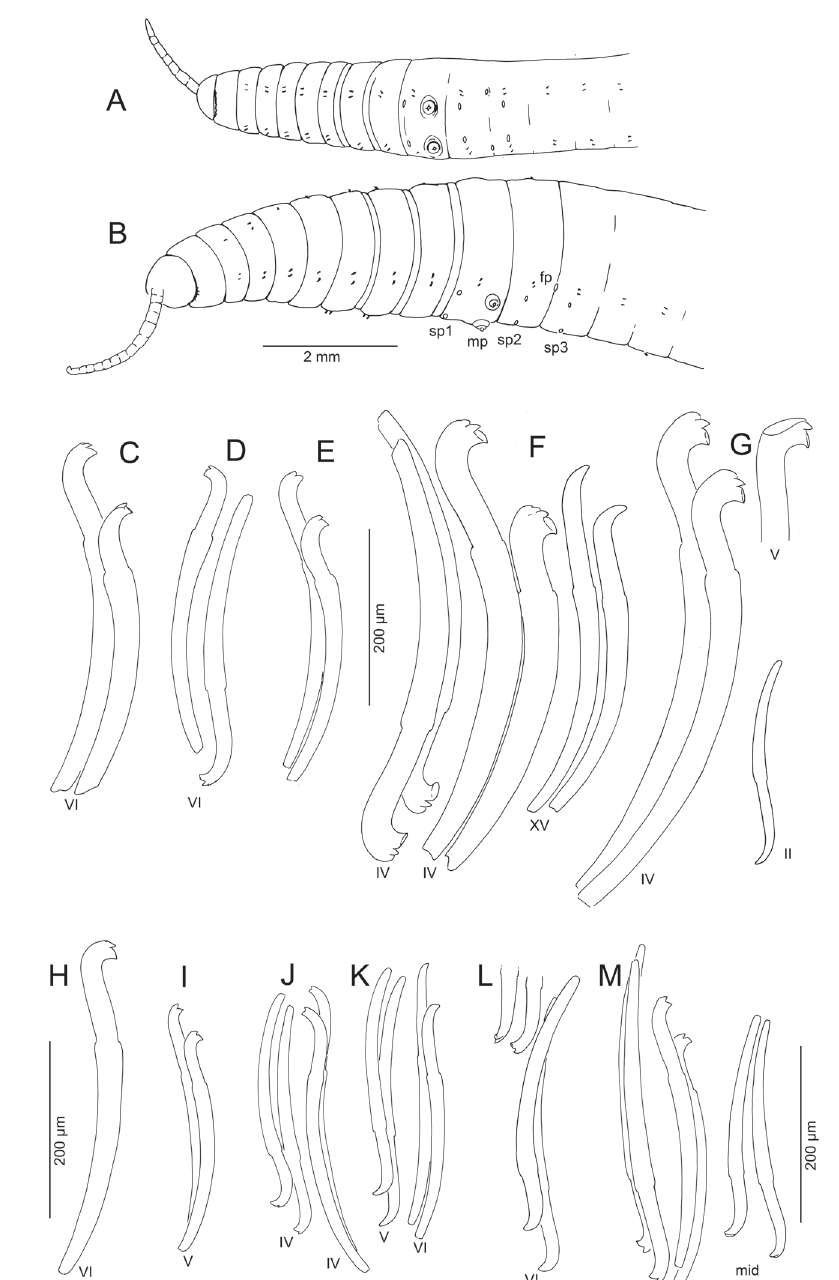
Fig. 1. Kincaidiana hexatheca Altman, 1936 from various sites. A–B . Complete worms, ventral view of anterior segments, from McKenzie River, OR (A), and from Big Creek, OR (B). C–M . Representative (mostly anterior) chaetae from different populations (ordered approximately north-south); dorsal chaetae with tips upward, ventrals with tips down. C . Hoh River, WA. D . Pool at Bogachiel River, WA. E . Salmon Creek watershed, WA, anterior dorsal pair. F–G . Two specimens from Big Creek, OR; tip of one dorsal chaeta with keel folded over. H . Rogue River, OR. I . From a Darlingtonia bog, O’Brien, OR. J–K . Two specimens from spring near Mule Creek, OR; K is from a smaller specimen, with simple-pointed chaetae. L . Illinois River, OR; older chaetae simple-pointed (worn?), replacements bifid. M . Inglenook Fen, CA. Scale bars: A–B = 2 mm; C–M = 200 m